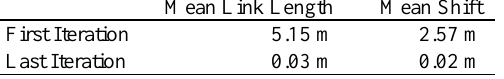
Table 5. Results for first and last iteration step for the